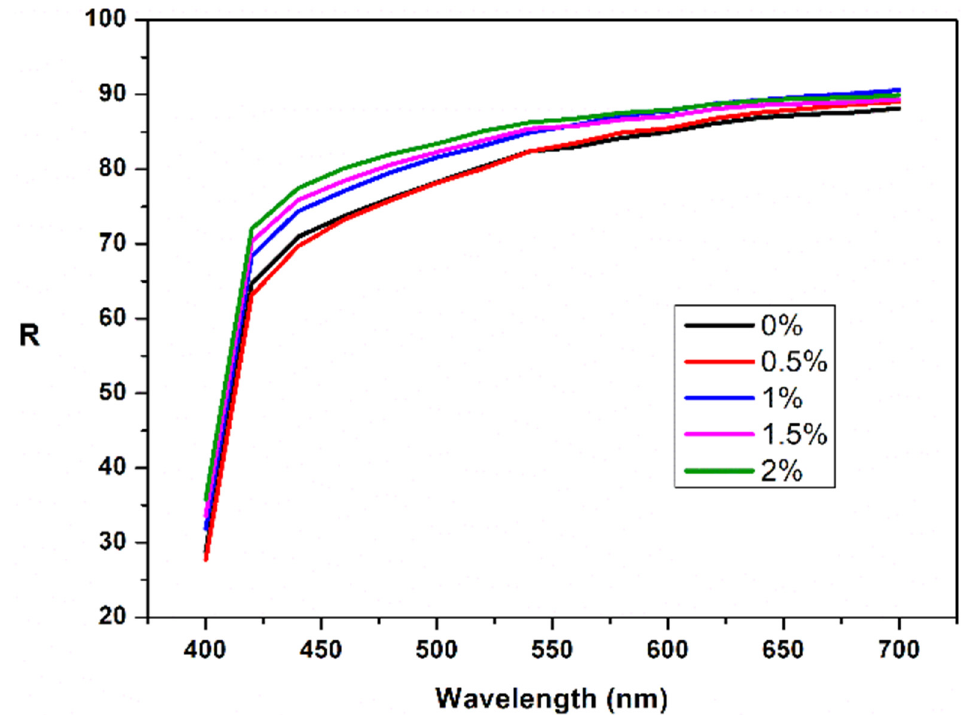
Figure 7. Reflectance spectra of the bioester B3 of the ester acrylic film at different ester concentration.